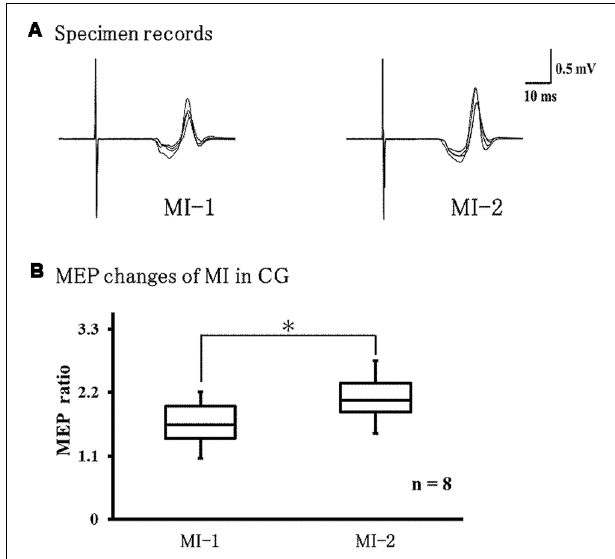
FIGURE 6 | Changes in MEPs during left-hand MI in the control group. (A) Representative EMG recordings from the extensor carpi radius muscles from a single subject in the control group, across two conditions. (B) Quantification of MEP ratio in the two conditions MEP ratio was significantly larger at MI-2 than at MI-1 ( p = 0.021). ∗ p <